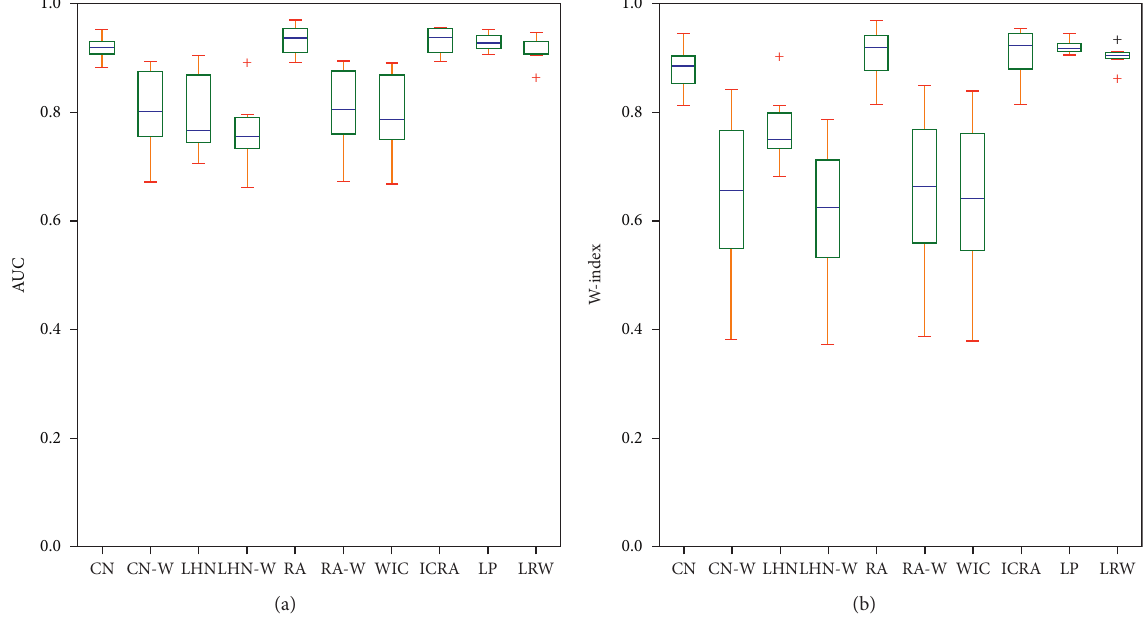
Figure 5: Statistical distributions of the performance of all measures measured by (a) AUC and (b) W-index. The line inside each box indicates the median of the prediction accuracies on six